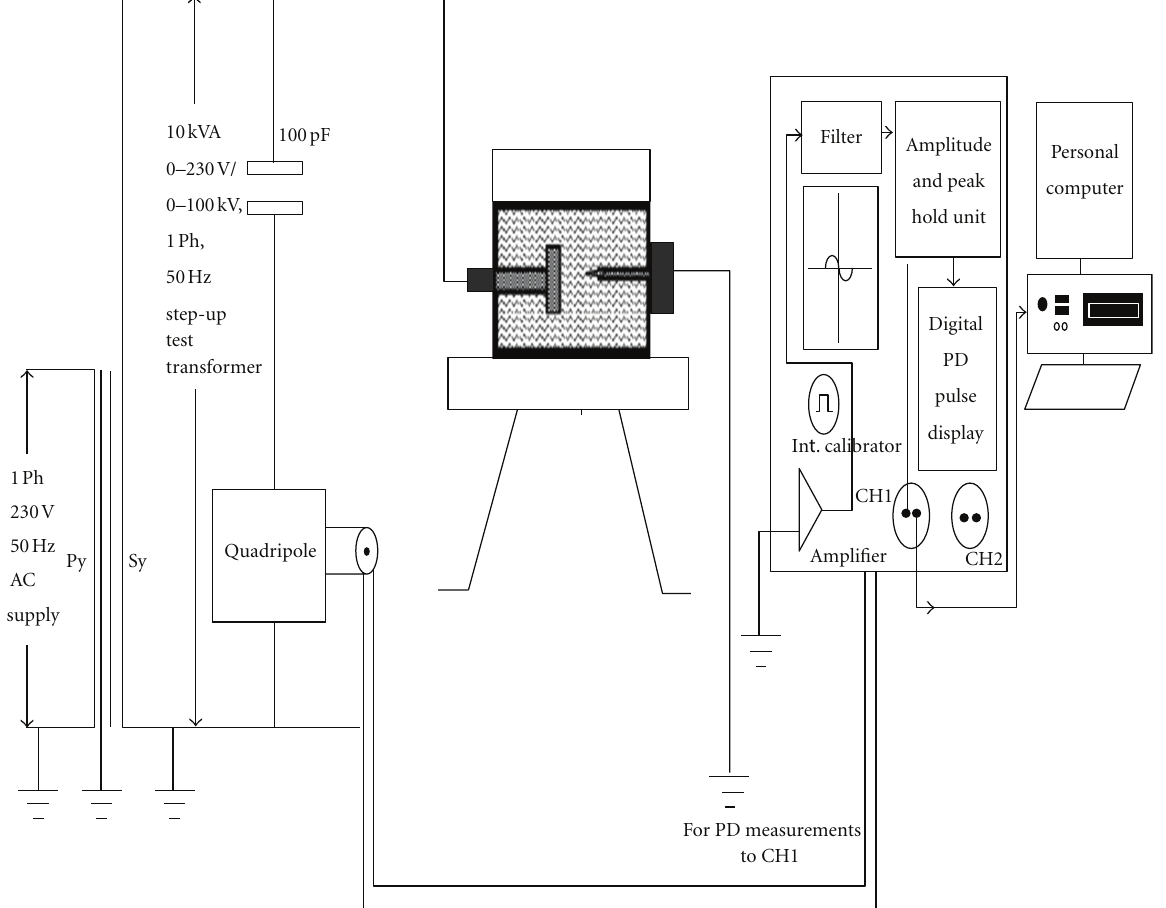
Figure 6: Typical laboratory test setup for PD pattern recognition studies.